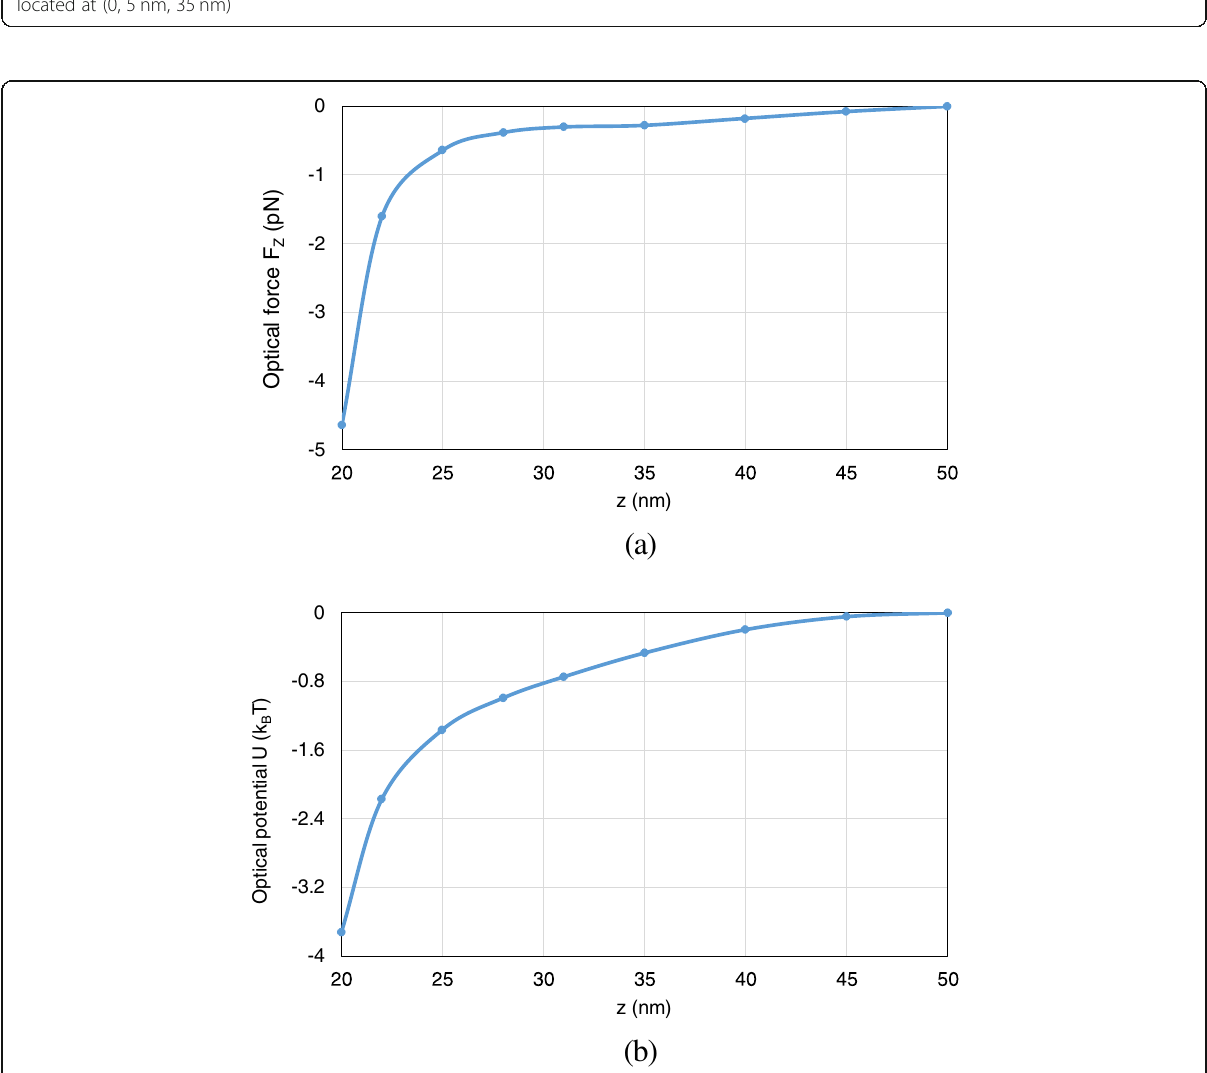
Fig. 12 Calculated results of optical forces exerted on the nanosphere in the system of gold truncated cone dimer varying λ . The nanosphere is located at (0, 5 nm, 35 nm)